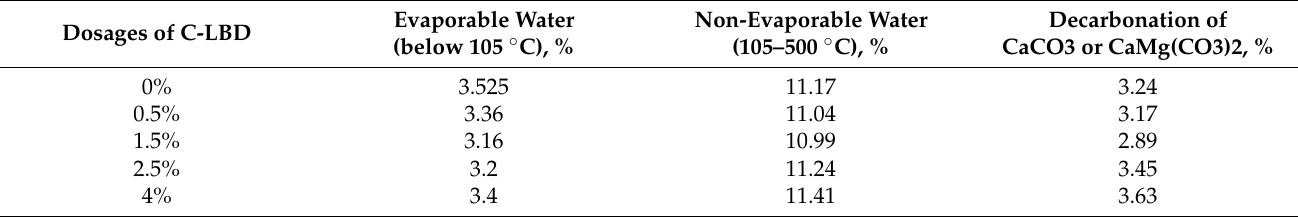
Table 3. Mass losses of the paste at different temperature ranges and corresponding processes.